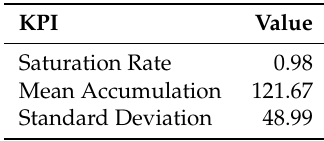
Table 2. KPI results obtained in loading